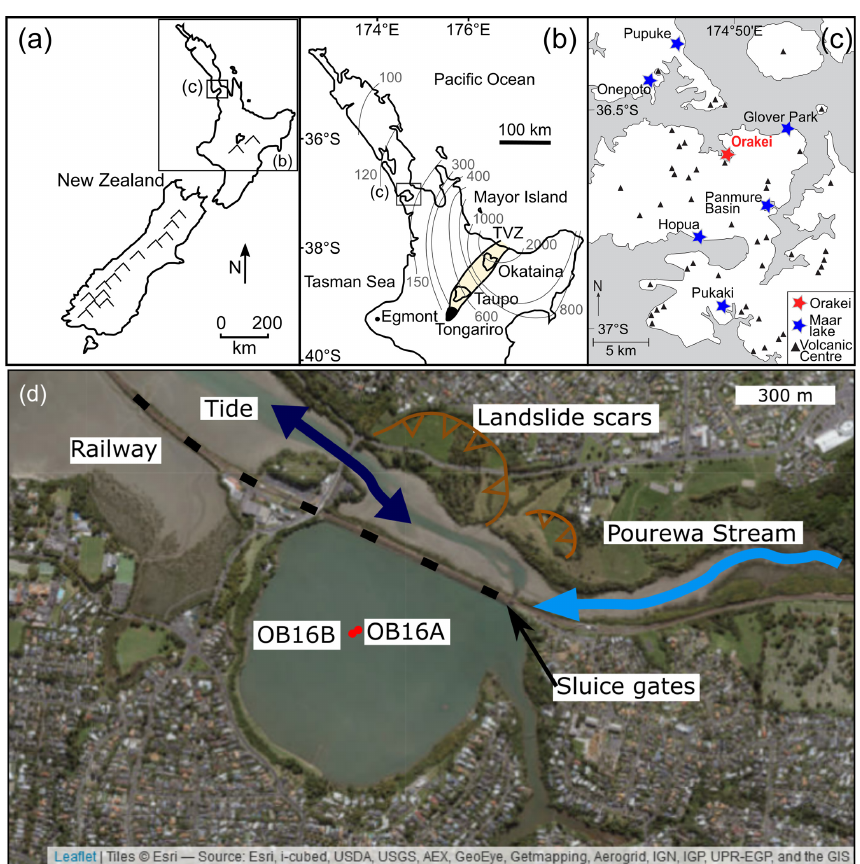
Figure 1. Map of the Orakei maar study area. (a) New Zealand with insets (b) and (c) marked. (b) New Zealand’s North Island with Auckland (c) and the major volcanic source centres marked; the extent of the TVZ is shaded in yellow. Thin grey lines and numbers are isopachs (in mm) of the widespread Rotoehu tephra (modified from Lowe, 2011) highlighting the importance of the TVZ tephras as age markers in sediment records from New Zealand’s North Island. (c) Auckland Volcanic Field showing the position of Orakei Basin. (d) Satellite image (ESRI World Imagery) show the coring locations with red dots and other important features of the surroundings of the maar. Modified after Hopkins et al. (2017) and Peti and Augustinus